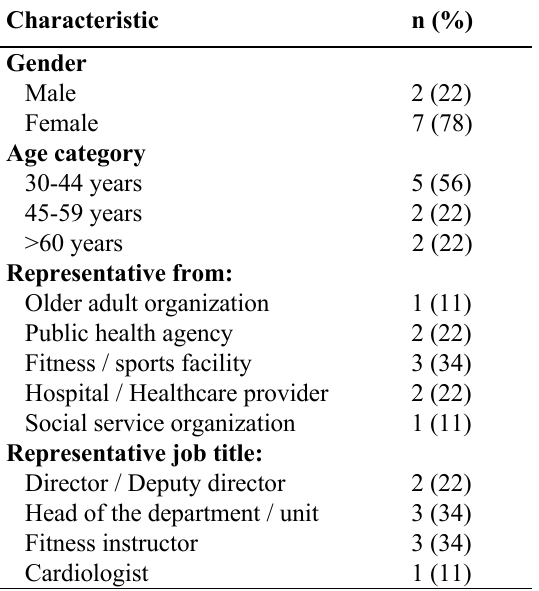
Table 2. Key informant characteristics (N=9) Community Readiness Scores